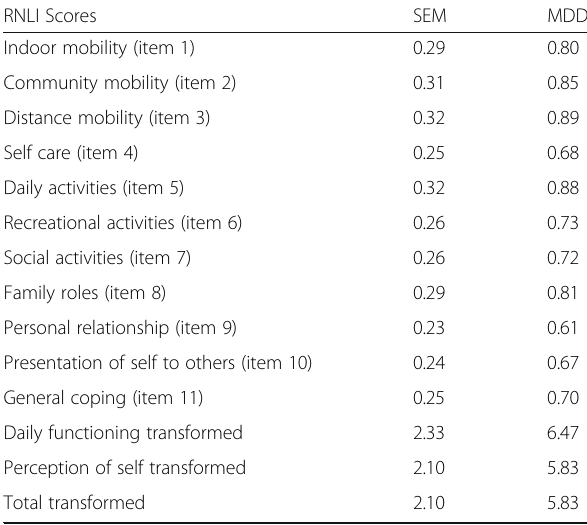
Table 4 Standard error of mean and minimum detectable difference of I-RNLI scores